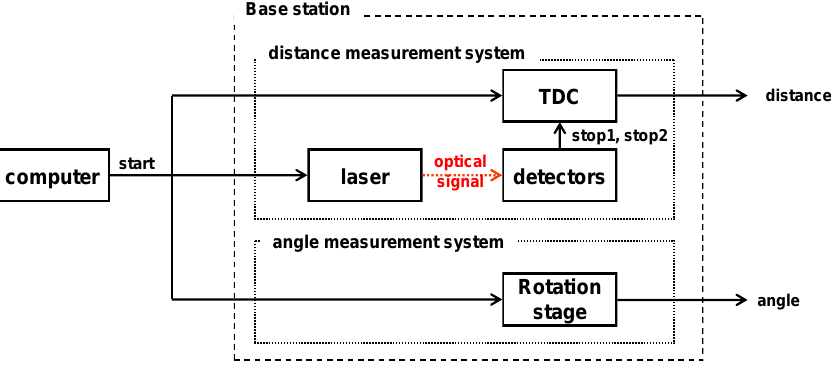
Figure 1. Block diagram of the ToF measurement